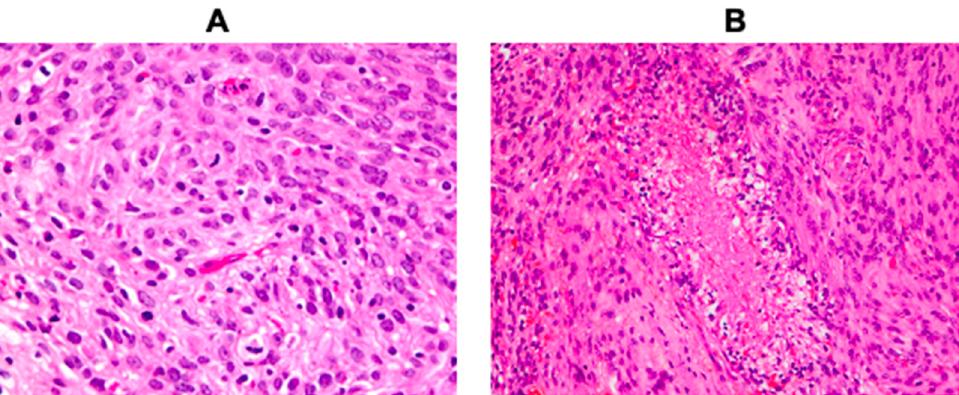
Figure 1. Histopathology of atypical meningiomas. ( A ) An atypical meningioma with several mitoses (40 × objective). ( B ) An atypical meningioma with hypercellularity and necrosis (20× objec- tive).